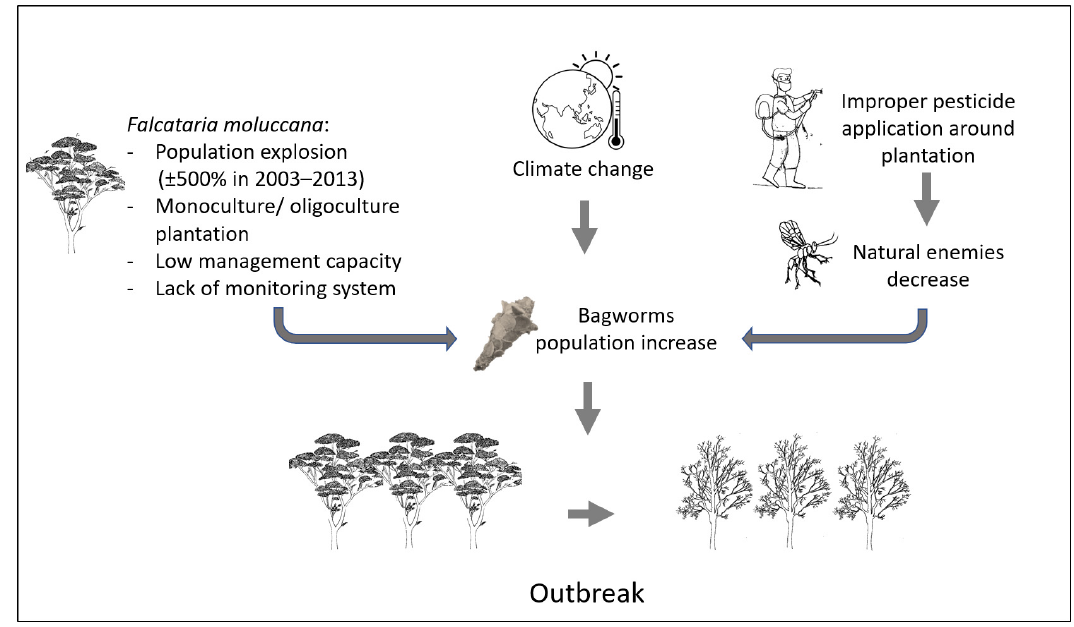
Figure 6. Schematic of Pteroma plagiophleps outbreak in a Falcataria moluccana plantation.